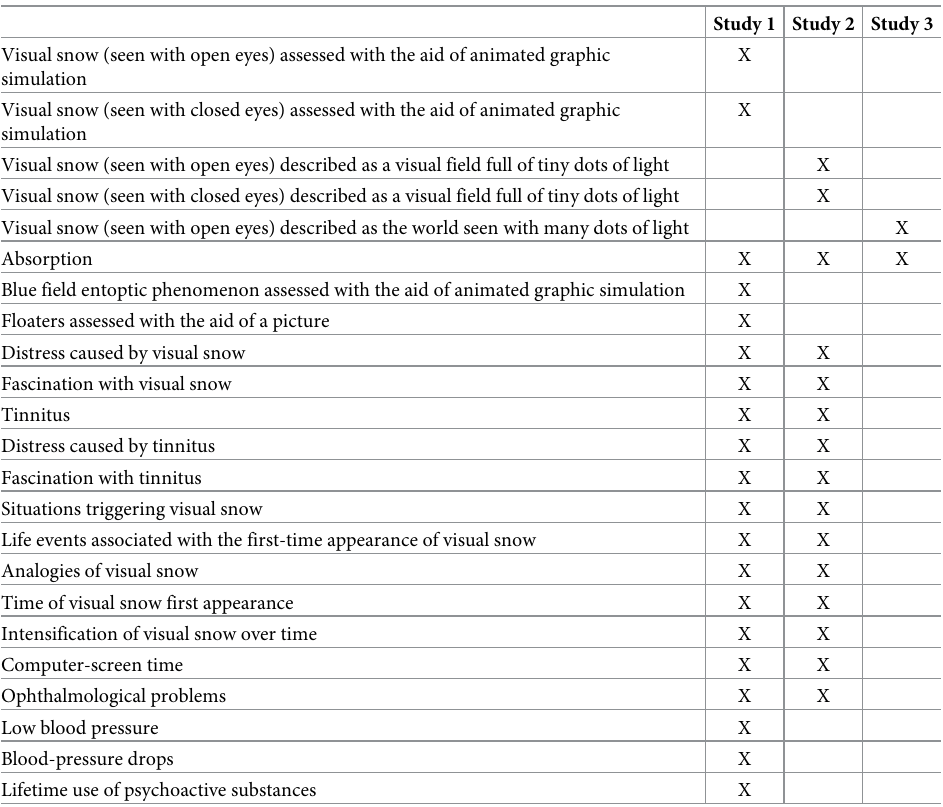
Study 1 Study 2 Study 3 X X X